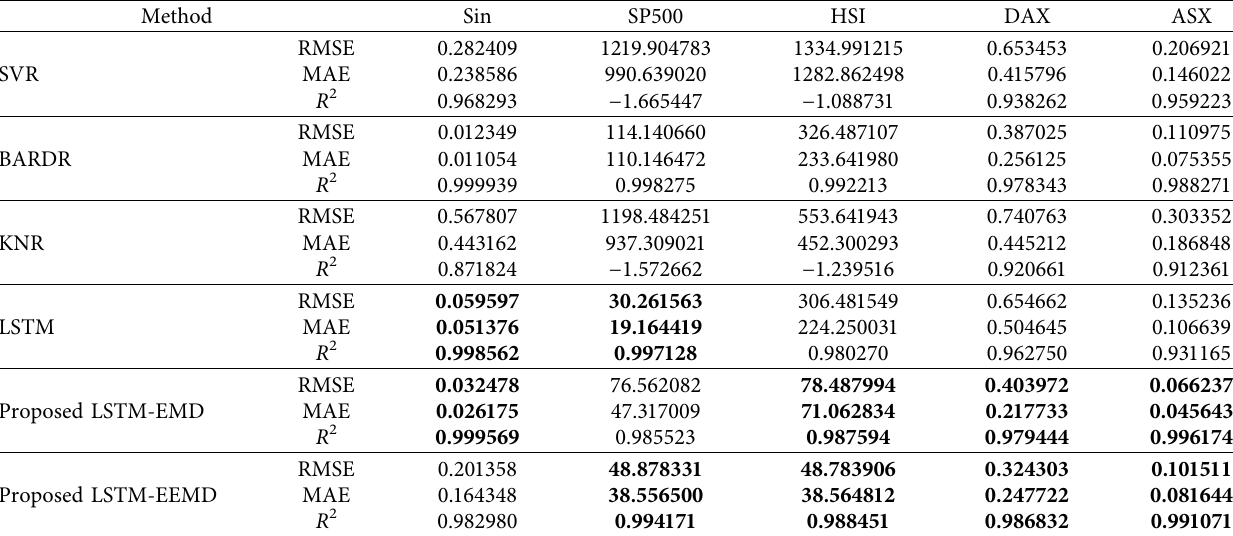
Table 1: Prediction results of time